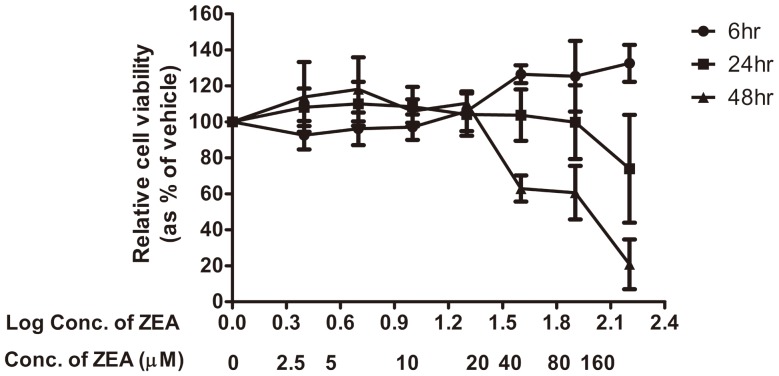
Cytotoxic effects of ZEA on BEAS-2B cells determined by MTT assay.Cells were treated with increasing concentrations of ZEA (from 0 to 160 µM) for 48 h. Cell viability was expressed as percentages of control (values taken as 100%) and are mean ± SD of at least 3 independent experiments. * represents p<0.05 significantly different from control as assessed by t-test.